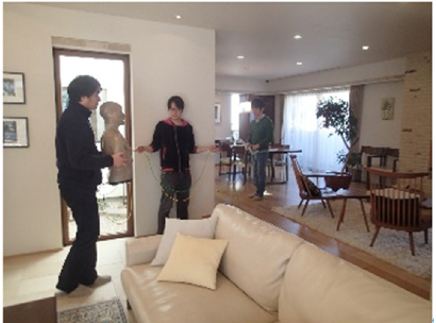
Figure 13. Binaural recording in the LD room. The experimenter holds the dummy head and walks around the room generating a footstep sound. around the room generating a footstep